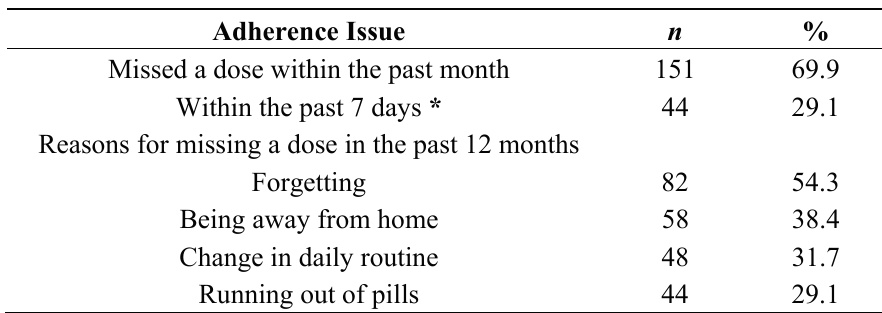
Table 2. Medication Adherence among Respondents who Received ARVs within the Past 12 Months ( n = 216)